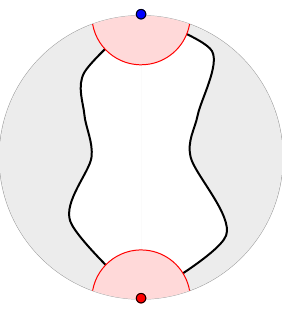
Figure 11. The shape of the two branes are fluctuating. The AdS 2 cutoff is induced by the AdS 3 cutoff (the red curve). The shaded regions are cutoff. Now the cutoff asymptotic boundary of the wedge are two